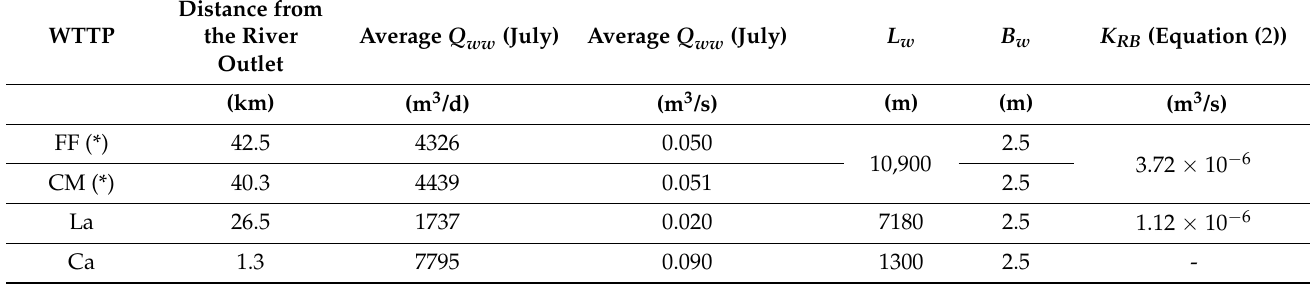
Table 2. Relevant distances of wastewater treatment plants (WWTPs) discharge points from the river outlet, flow rates, and channel features used for the estimation of average riverbed hydraulic conductivity. FF = Francavilla Fontana; CM = Ceglie Messapica; La = Latiano; Ca = Carovigno. L w = length of the downstream wet stretch; B w = mean width of the downstream wet stretch. (*) Given the short distance between the FF and CM effluent discharge location, they have been treated as a unique point, positioned in FF, with a total effluent discharge equal to the sum of the